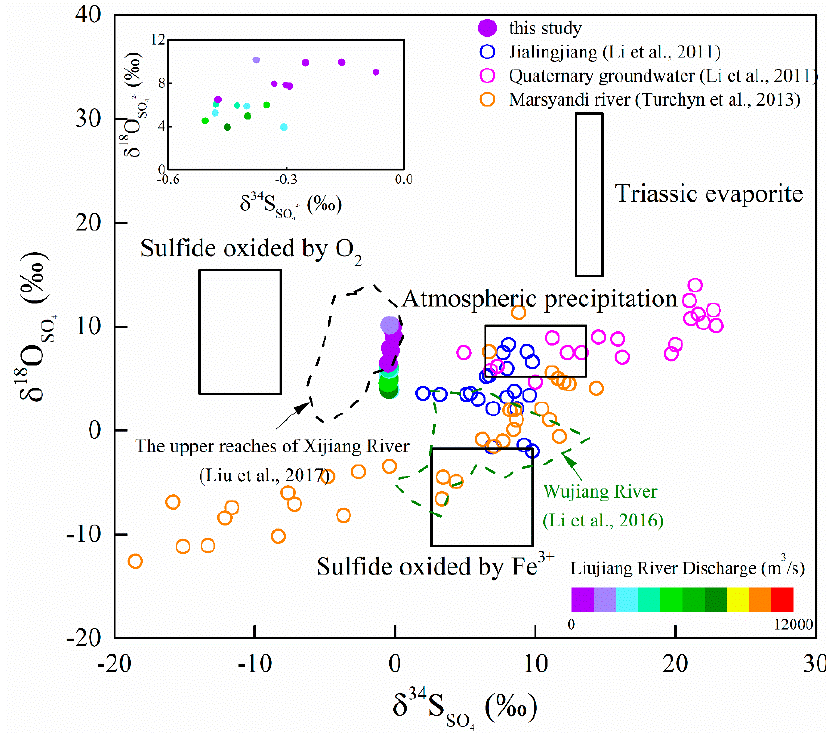
Figure 4. A diagram of δ 34 S SO4 versus δ 18 O SO4 showing the riverine sulfate sources produce isotopically distinct sulfate in the Liujiang River [3,35,39,41,45].